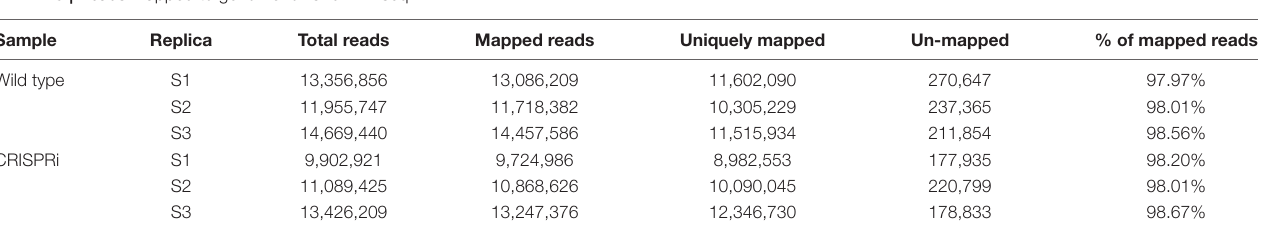
TABLE 5 | Reads mapped to genome for CircRNA-seq.